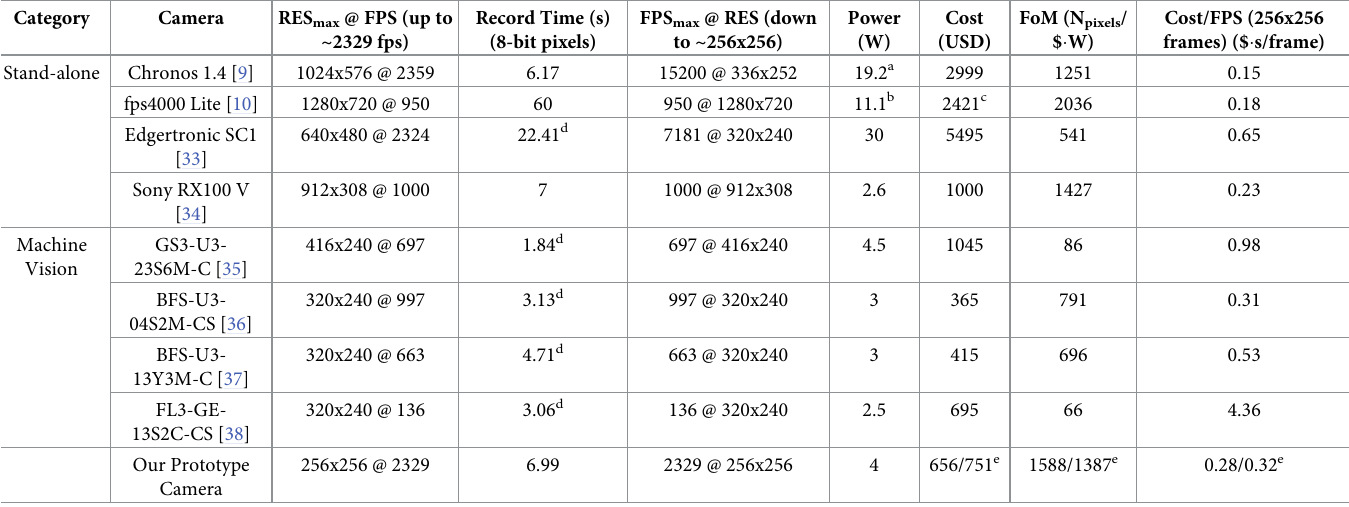
Table 4. FoM comparison of several low-cost, high-speed cameras against our